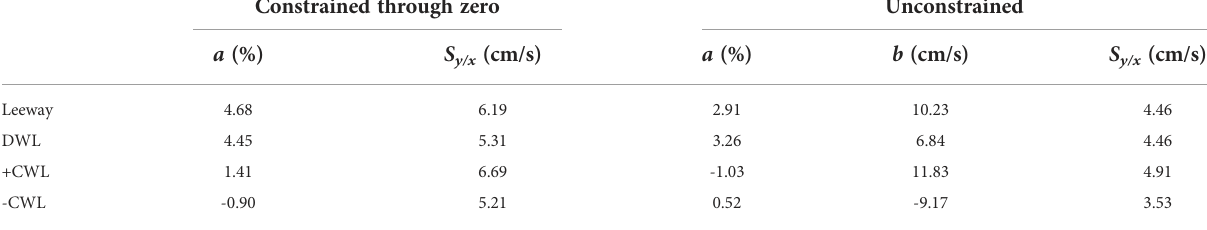
TABLE 6 The regression coef fi cients and standard errors of improved model. Constrained through zero